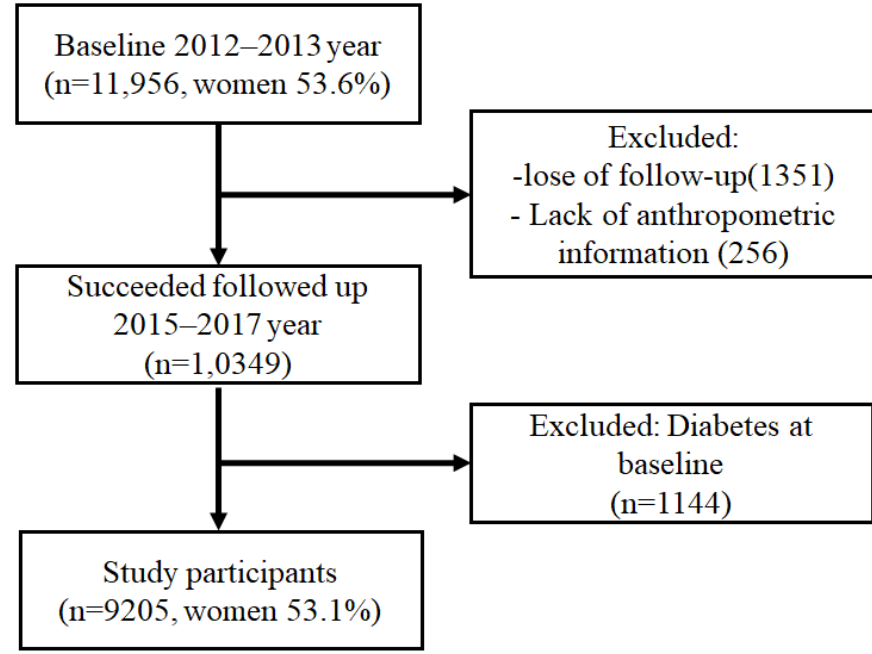
Figure 1. The recruitment process of the study population.